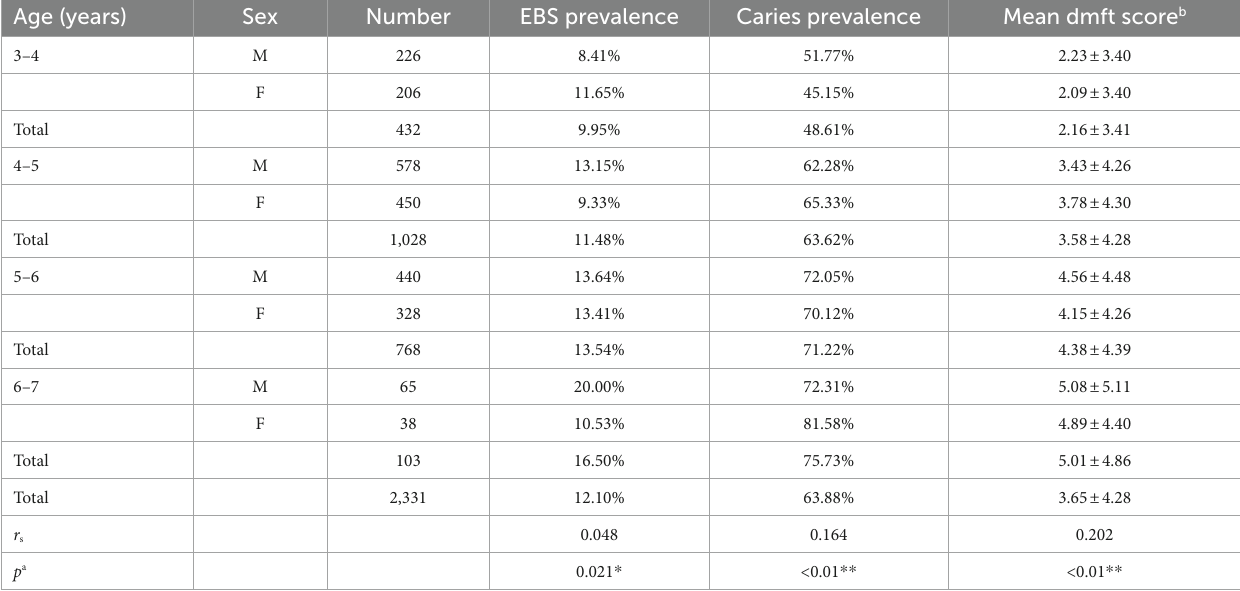
TABLE 4 Caries and extrinsic black stain (EBS) patterns according to age group.